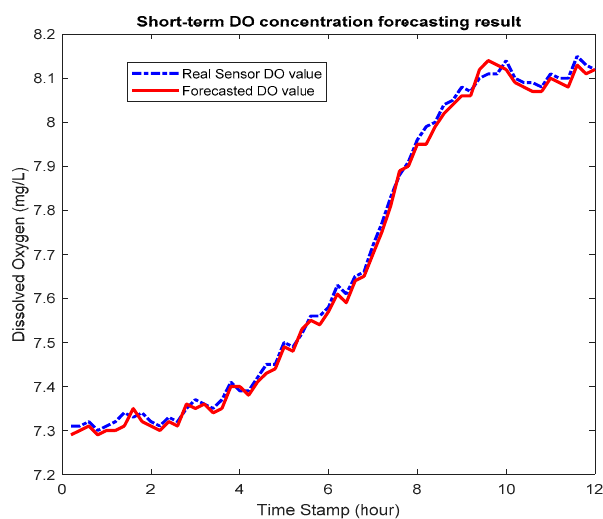
Figure 6. Short-term (6 h) forecast result measured against actual dissolved oxygen (DO) concentration values.